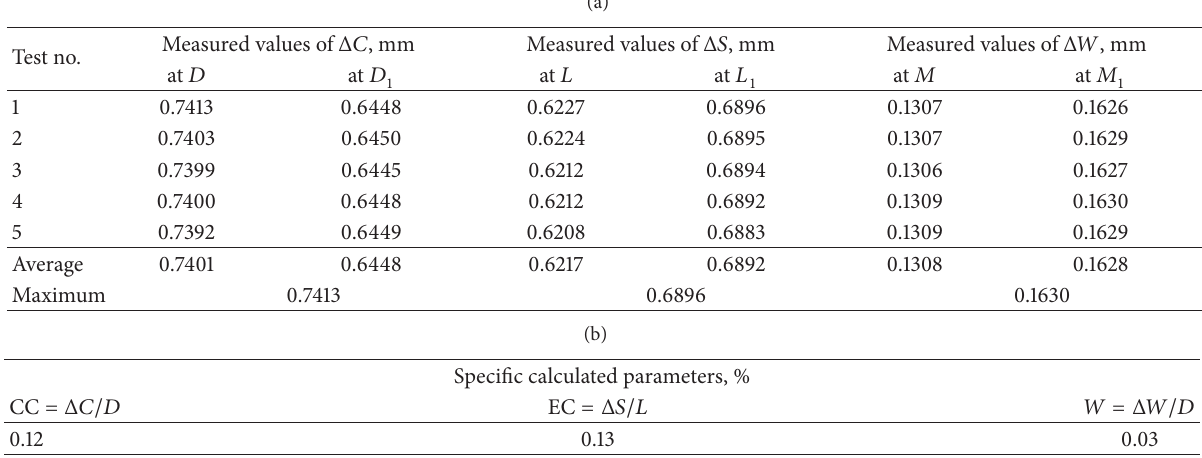
Table 9: The classification results of tile third sample using new measurement method in mm.